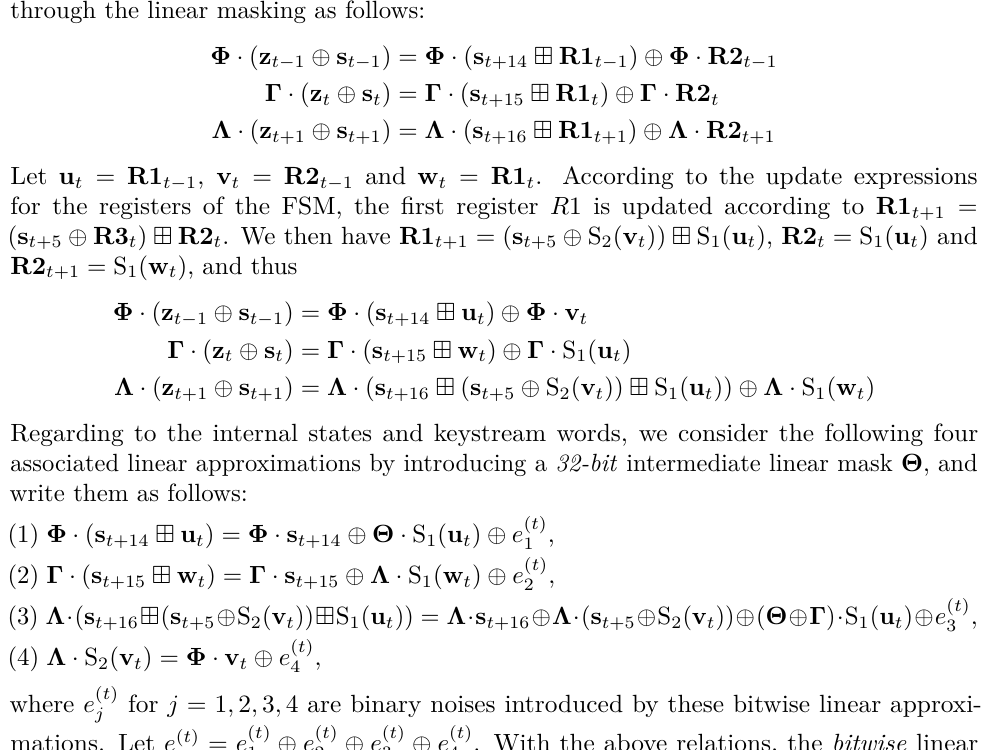
Figure 5: The three-round bitwise linear approximations for the FSM of SNOW 3G Generally, to build the bitwise linear approximation of the FSM of SNOW 3G,